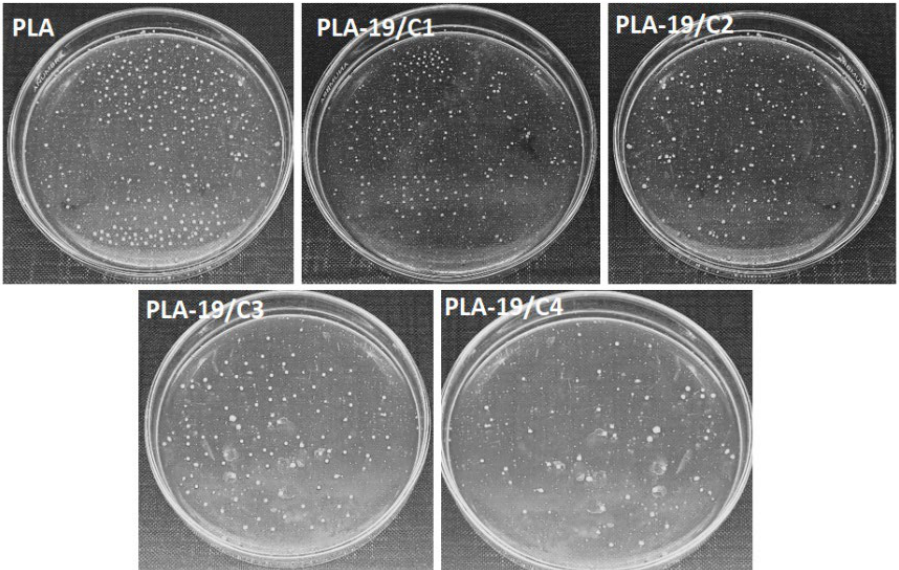
Figure 9. Quantitative measurement of antimicrobial activities of 19% PLA nanofibers with different CND concentrations against S. aureus bacteria.